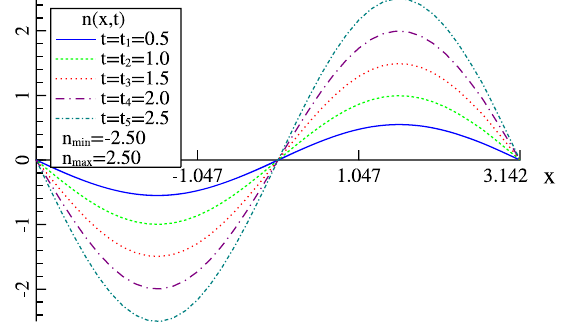
FIG. 2. Numerical solution of the 1D Laplace-Fredholm equation (108) with kernel (109) and left-hand side (110) obtained via the PPCM and Laplace transform inversion via